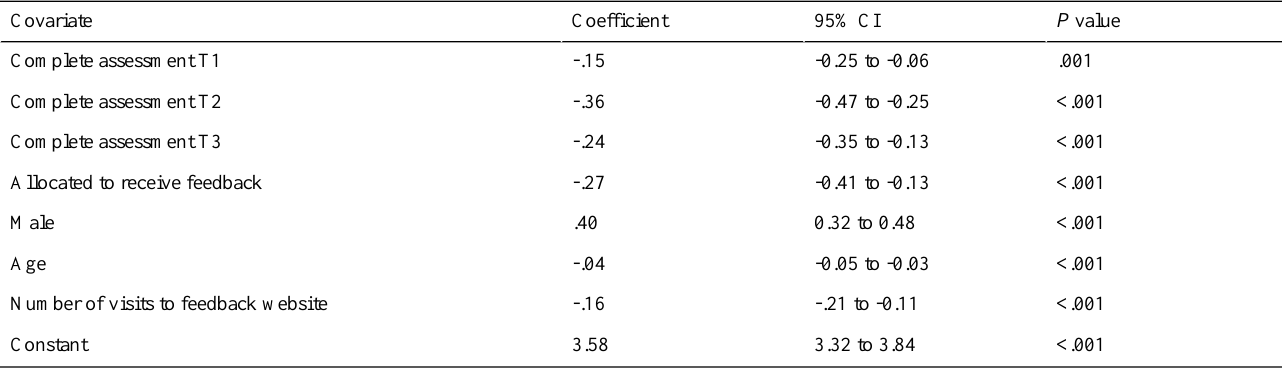
Table 3. Table of coefficients for longitudinal regression model: log (1+units consumed over the last week) regression on assessment completed, condition allocation, sex, age, and number of visits to website by restricted maximum likelihood.